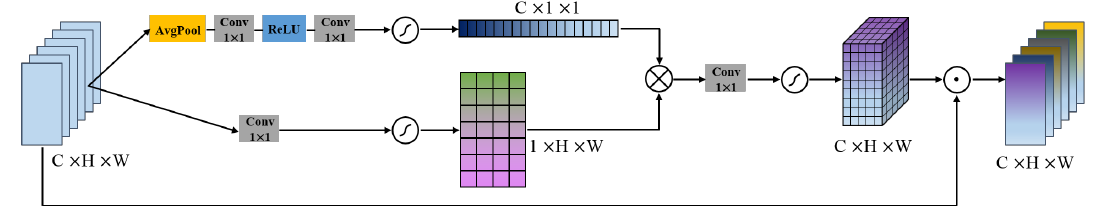
Figure 3. The structure of the cross-dimension attention module. C × H × W denotes a feature map with the number of channels C , the height of H and the width of W . ⊗ denotes matrix multiplication. (cid:12) denotes element-wise